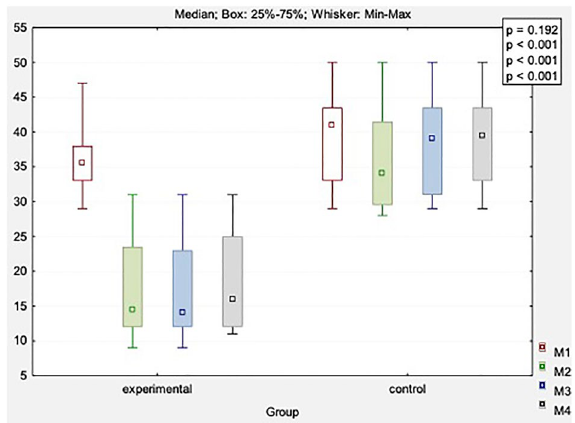
Figure 3. Comparison of changes in functional status (ODI) obtained in four measurements between study and control group. M1, before treatment; M2, after treatment; M3, 1 month after study; M4, 3 months after study.